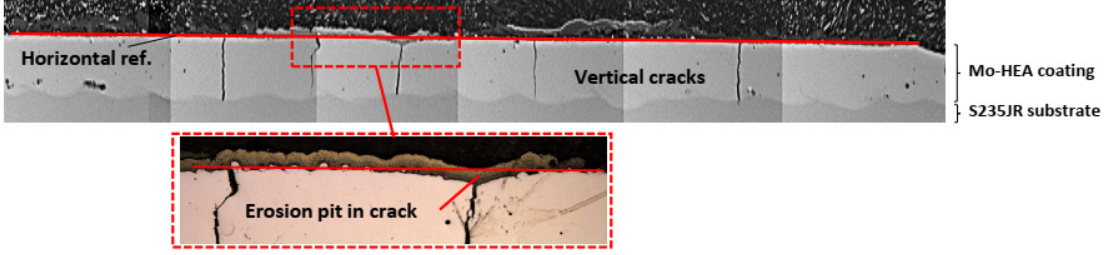
Figure 15. The surface profile of Mo-HEA coating in the Mo-HEA-S235JR sample after the exposure in the erosion testing. The erosion pit was concluded to have formed in one of the vertical cracks in the Mo-HEA coating.